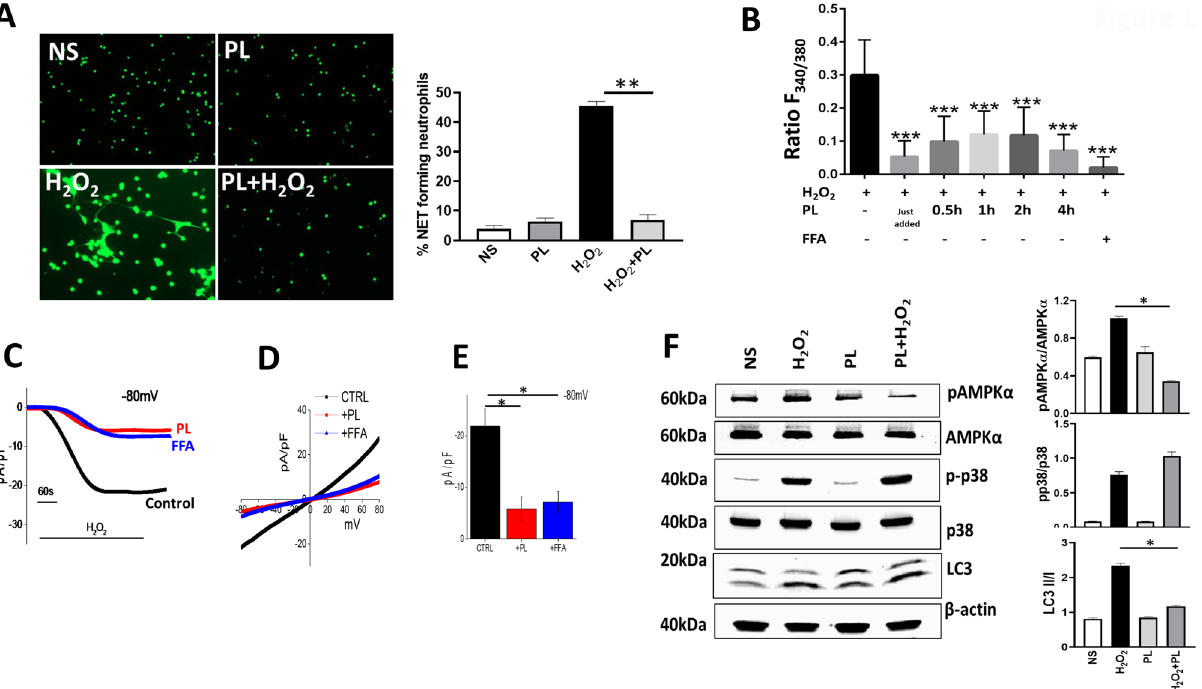
Figure 1. PL inhibits ROS induced TRPM2 activation and NET formation. ( A ) Peritoneal neutrophils were stimulated with 5 mM H 2 O 2 for 4 h with or without PL pretreatment (25 µg/ml). Representative fluorescence images of Sytox Green stained NETs at magnification 200X are shown. Bar graph shows quantitation of NETs as average ± SE from 3 independent experiments. (**p < 0.01). ( B ) Ca 2+ imaging was performed as described in methods in H 2 O 2 stimulated neutrophils with and without 0.1 mM FFA or 25 µg/ml PL for indicated times. Bar graph shows quantification (mean ± SD) of the fluorescence ratio (F 340/380 ) from an average of 40–60 cells in 3 independent experiments. (***p < 0.001). ( C ) The TRPM2 like current in H 2 O 2 stimulated peritoneal neutrophils was measured by whole cell patch clamp method in the presence or absence of 0.1 mM FFA